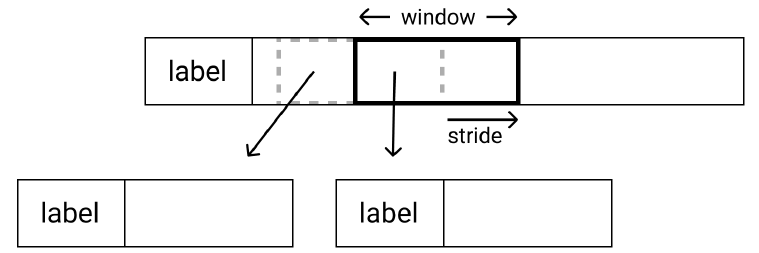
Figure 3. Sliding window dataset augmentation.